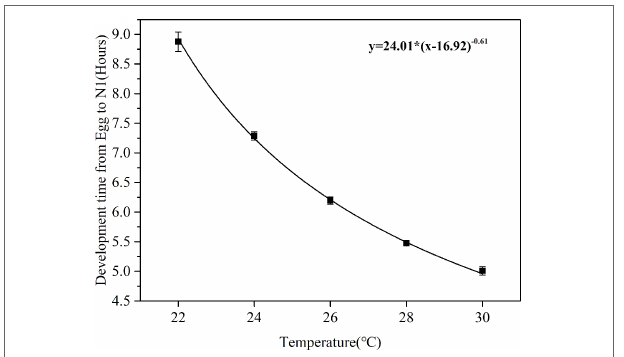
FIGURE 2 | Correlation curves between egg development time (D) and water temperature (T) in B. amoyensis (N=30). Data are presented as mean± standard error (SE).